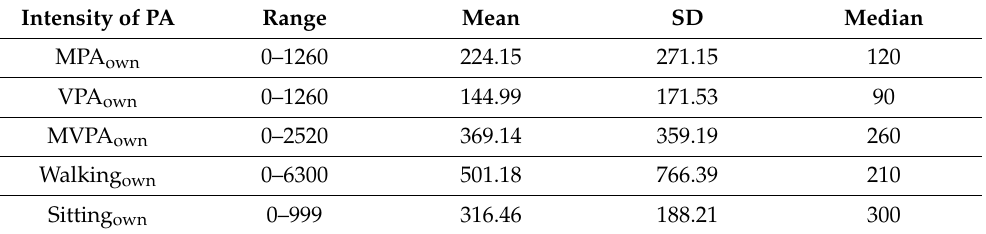
Table 3. Mean, Median and SD of own PA behaviour of the respondents.